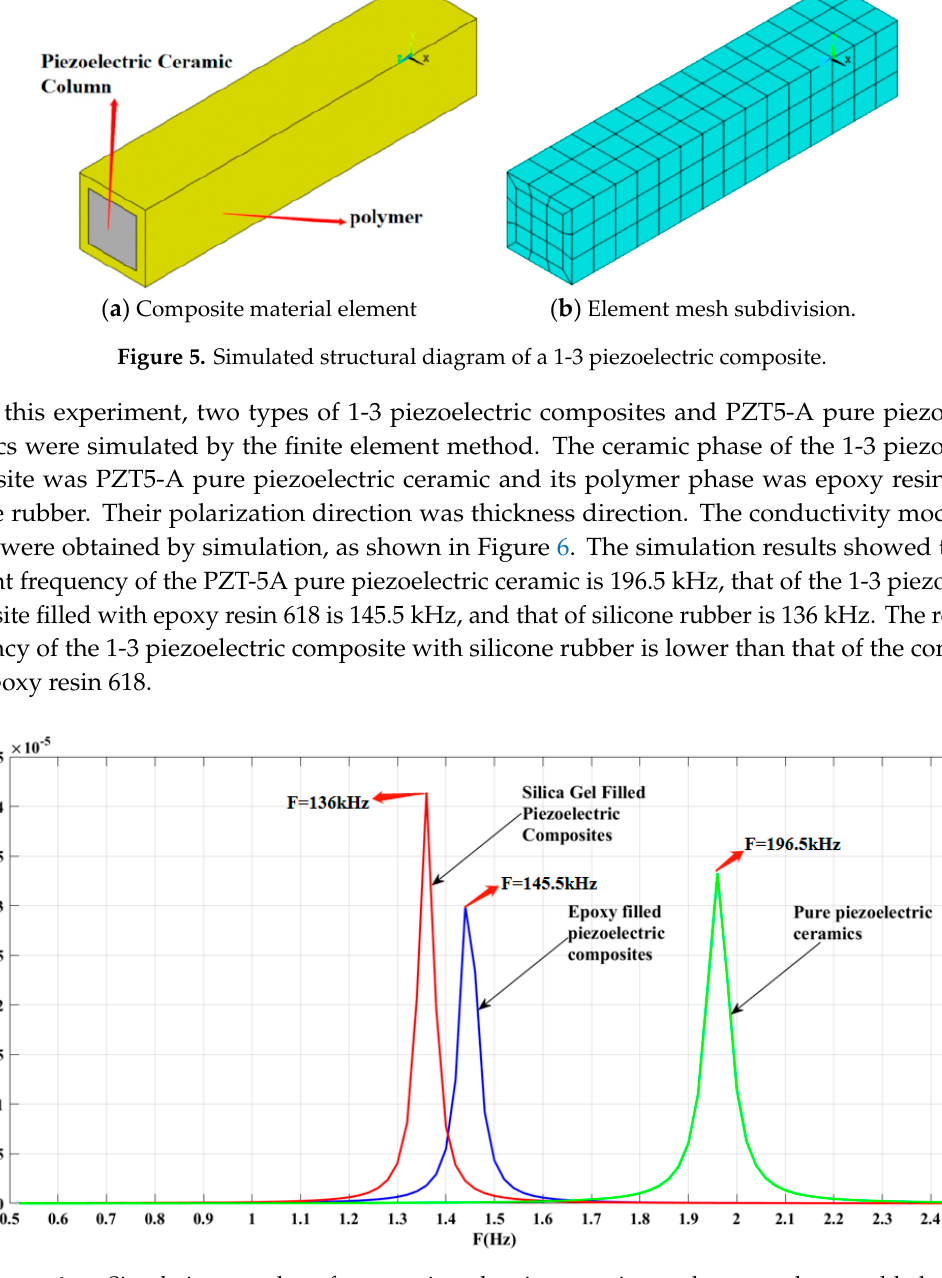
Figure 6. Simulation results of pure piezoelectric ceramics and two polymer-added 1-3 piezoelectric composites.